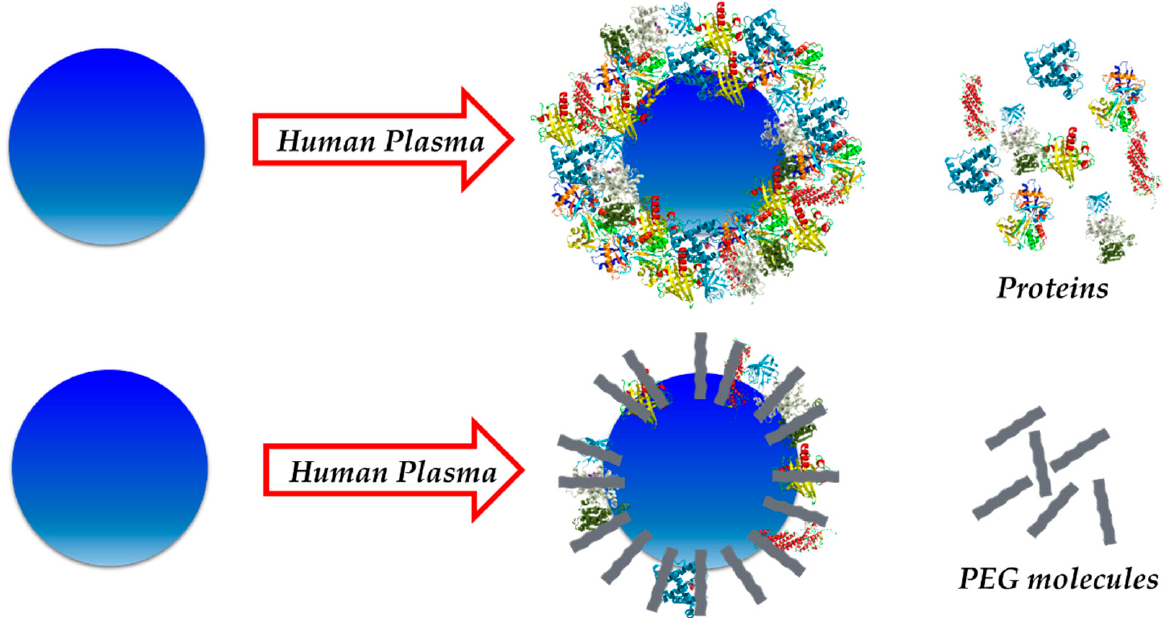
Figure 4. PEGylation of NPs minimizes interaction between proteins and NPs, leading to the formation of a smaller protein corona (PC) (cross-section view).